Question: Which kind of chart has been used to present this data?
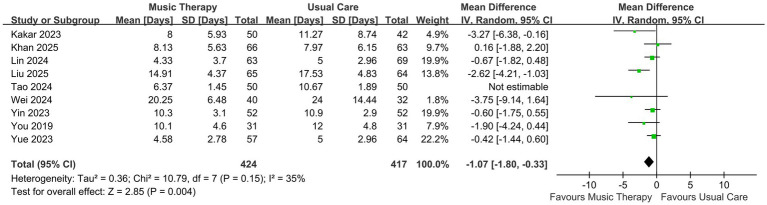
Answer: forest